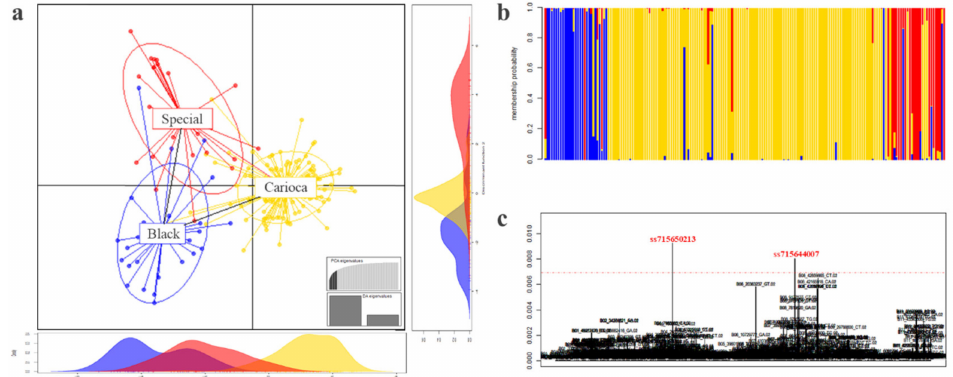
Figure 3. Discriminant analysis of the principal components carried out for the 185 Brazilian common bean cultivars. ( a ) Scatter plot of the two main components grouped by commercial class (colors and ellipses). ( b ) Representation of the compoplot function, showing the membership coe ffi cient of each cultivar to each group (i.e., commercial class) ordered according to commercial class (i.e., Black,